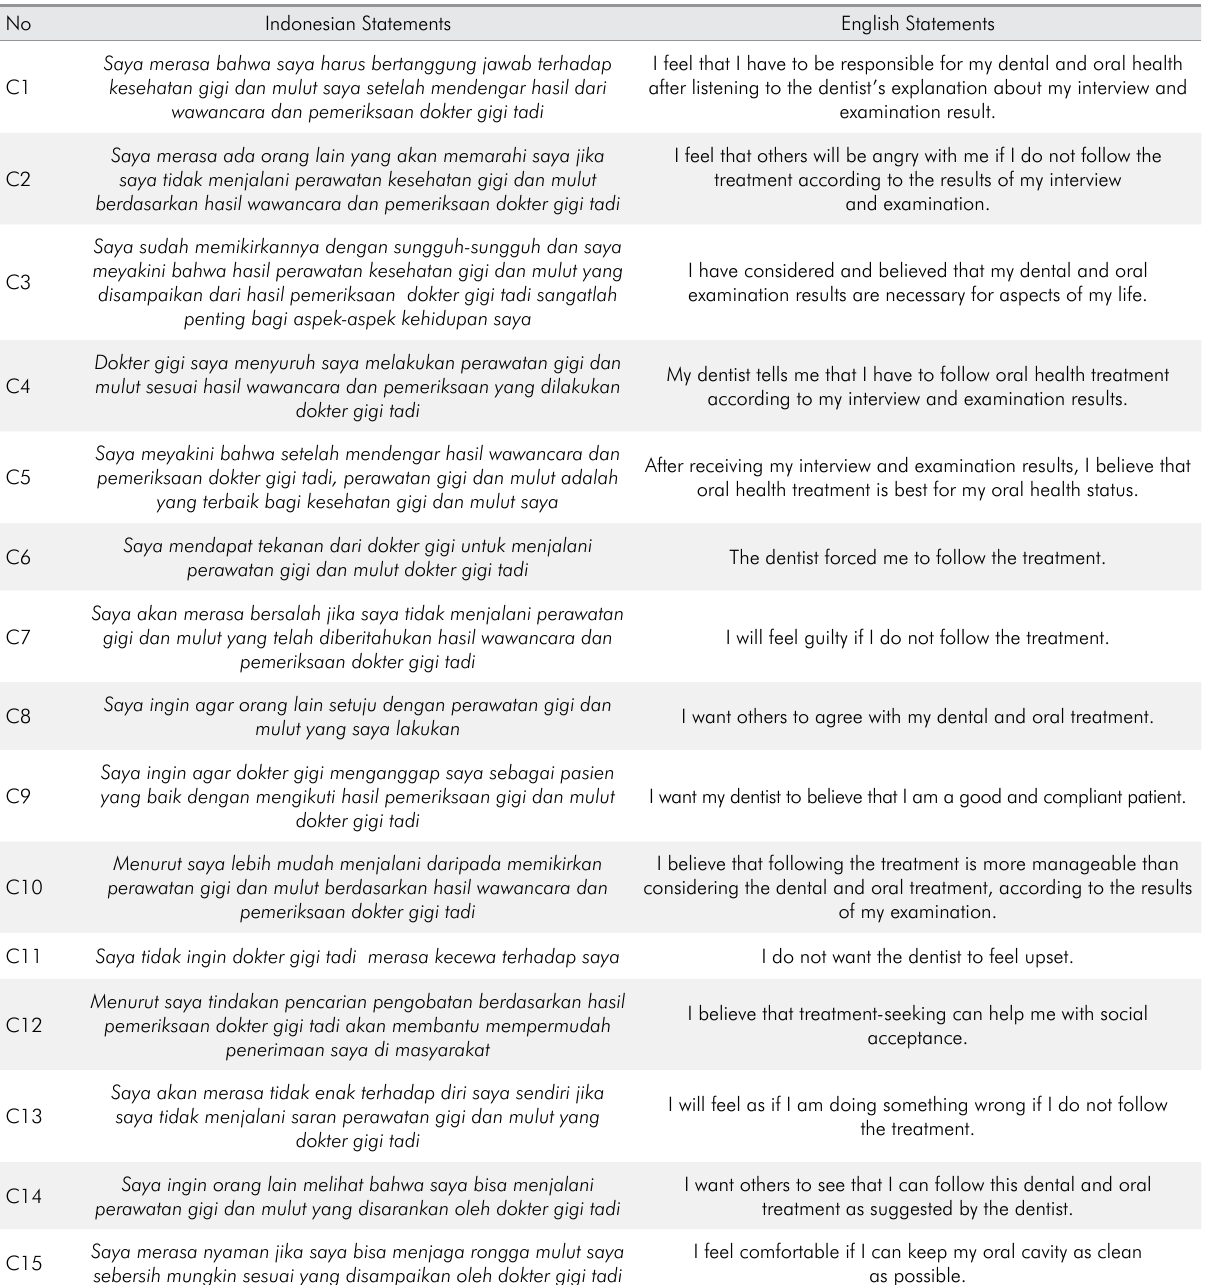
Table 3. The Indonesian and English version of the DTMS Modification as Cross-Cultural Adaptation Result No